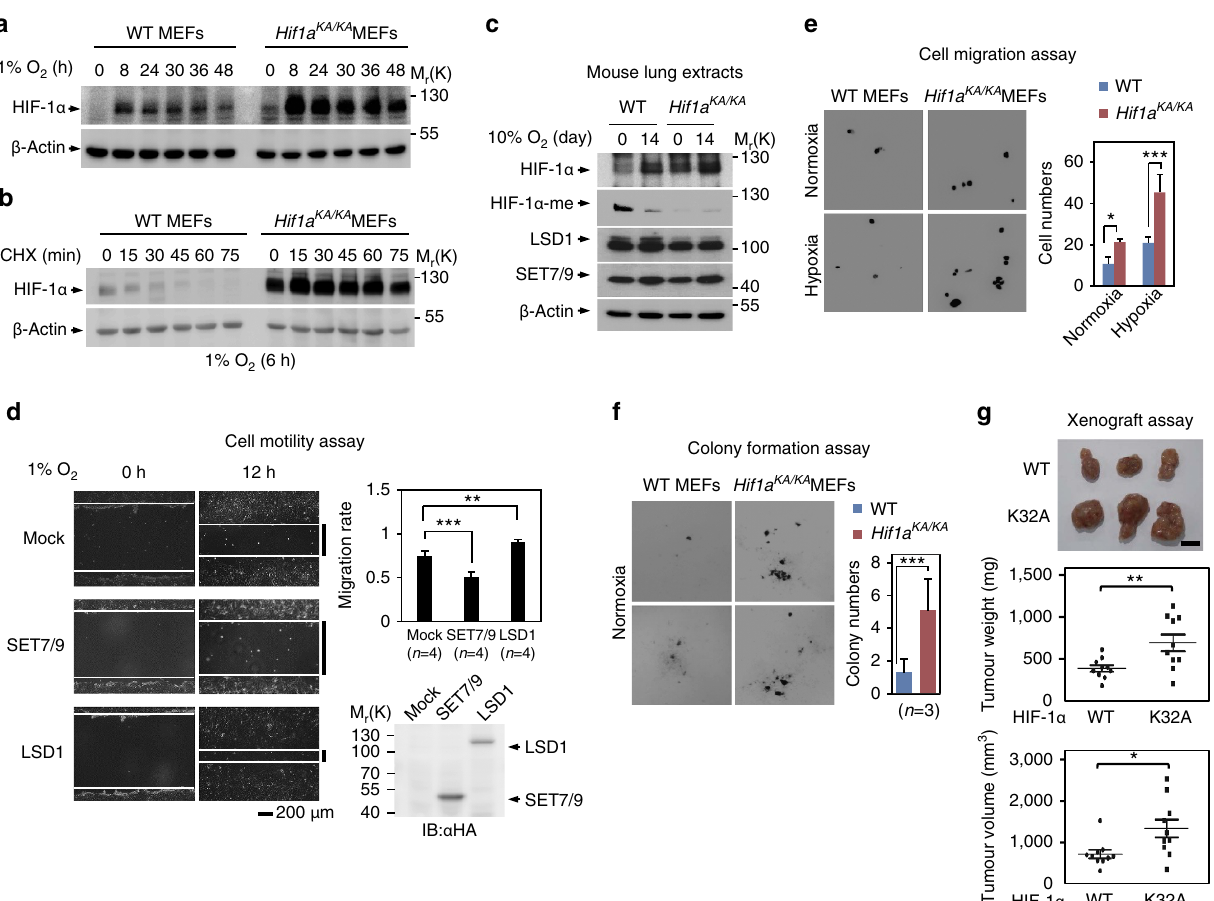
Figure 4 | Altered cell function and tumour growth of Hif1a KA/KA MEFs. ( a ) HIF-1 a protein levels in WT and Hif1a KA/KA MEFs were compared at the indicated times after hypoxic challenge. ( b ) The half-lives of HIF-1 a in WTand Hif1a KA/KA MEFs were compared in cells treated with cycloheximide (CHX) at the indicated times after 6h of hypoxic challenge. ( c ) IB analysis of mouse lung extracts was performed. Mice were incubated in a hypoxia chamber (10% O 2 ) for 14 days. ( d ) Representative photomicrographs from a scratch-cell motility assay of MEFs expressing either SET7/9 or LSD1 under hypoxic conditions for the indicated times. Migration rate was calculated and expressed as ratio of cell coverage to the initial cell-free zone. Scale bar, 200 m m. Data are expressed as mean ± s.d. for four independent experiments ( n ¼ 4 for each group, t- test, ** P o 0.01, *** P o 0.001). ( e ) Photomicrographs from Transwell cell migration assays of WT and Hif1a KA/KA MEFs under normoxic and hypoxic conditions for 12h. Representative images are shown for each group. Bar graph shows the mean number of cells per filter ± s.d. ( n ¼ 4 for each group, t -test, *** P o 0.001). ( f ) Anchorage-independent growth of WTand Hif1a KA/KA primary MEFs in soft agar. Representative images are shown for each group. Values are expressed as mean ± s.d. ( n ¼ 3, t- test, *** P o 0.001). Colonies were counted in 15 fields. ( g ) In vivo xenograft assay of MDA-MB231 cells stably expressing HIF-1 a shRNA with reconstituted HIF-1 a WT or K32A. Vertically presented tumours were derived from same nude mouse at the left flank, WTat the right flank, K32A. Scale bar, 10mm. Tumours were excised from nude mice and tumour weight and volumes were measured ( n ¼ 10, t- test, * P o 0.05, ** P o